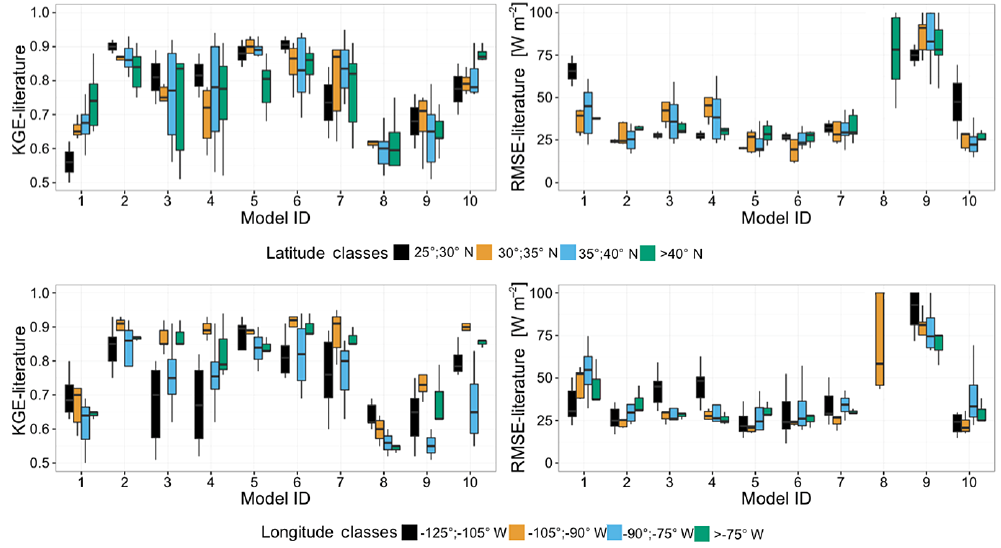
Figure 4. KGE and RMSE values for each clear-sky simulation using literature formulations, grouped by classes of latitude and longitude. Only values of KGE above 0.5 are shown. Only values of RMSE below 100Wm − 2 are shown.